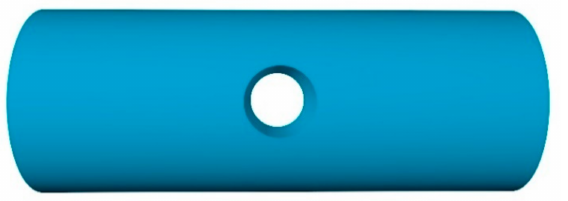
Figure 17. The schematic diagram of the side-hole structure POFs.